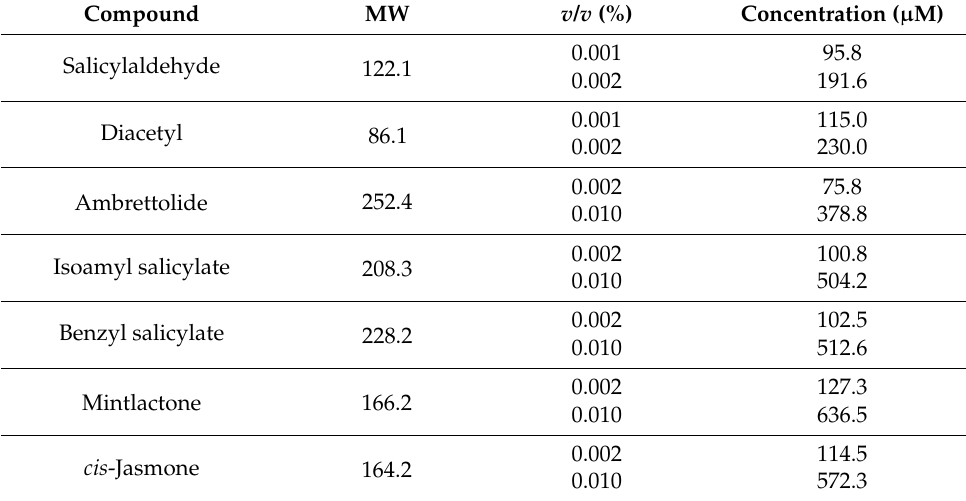
Table 2. Molecular weights and concentrations of compounds analyzed in Figure